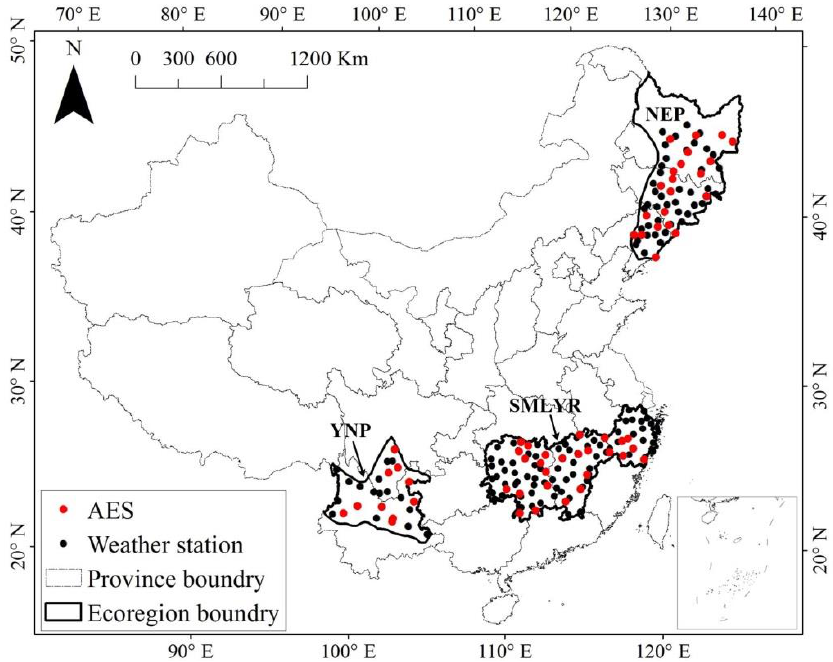
Figure 1. The study region, weather stations (black dots) and agro-meteorological experimental stations (AES, red dots) used in this study. NEP, YNP and SMLYR represent North Eastern Plain, Yunnan Plateau and South of Middle and Lower reaches of Yangtze River, respectively. AES: agrometeorological experimental station.